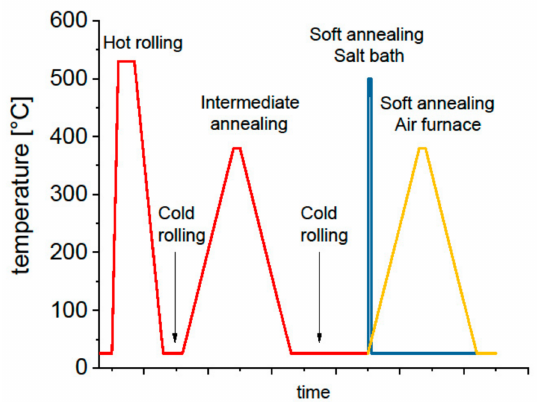
Figure 2. Schematic depiction of the thermomechanical processing